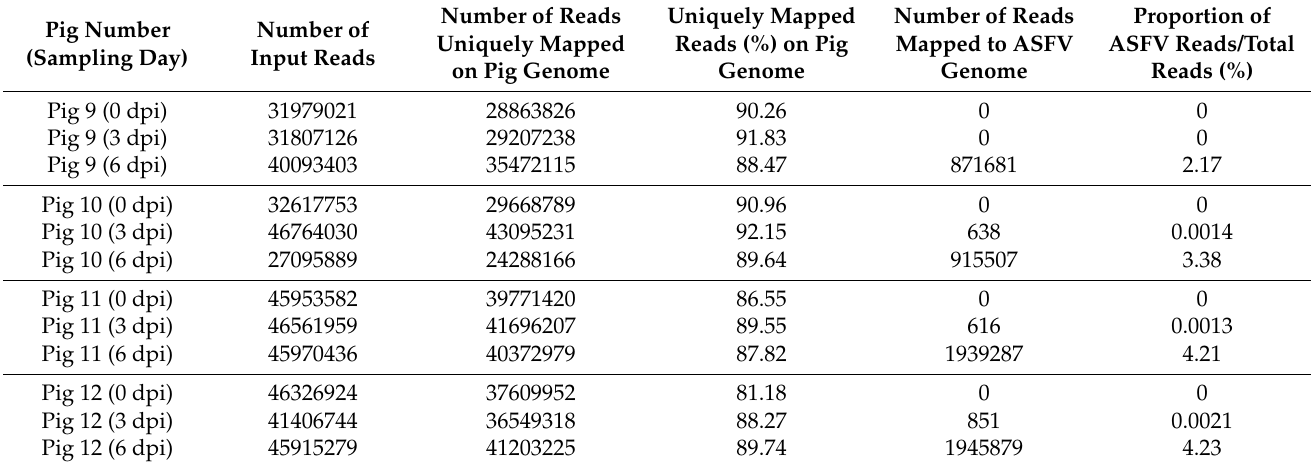
Table 2. Poly(A)+ mRNA derived sequence reads from PBMCs of pigs infected with